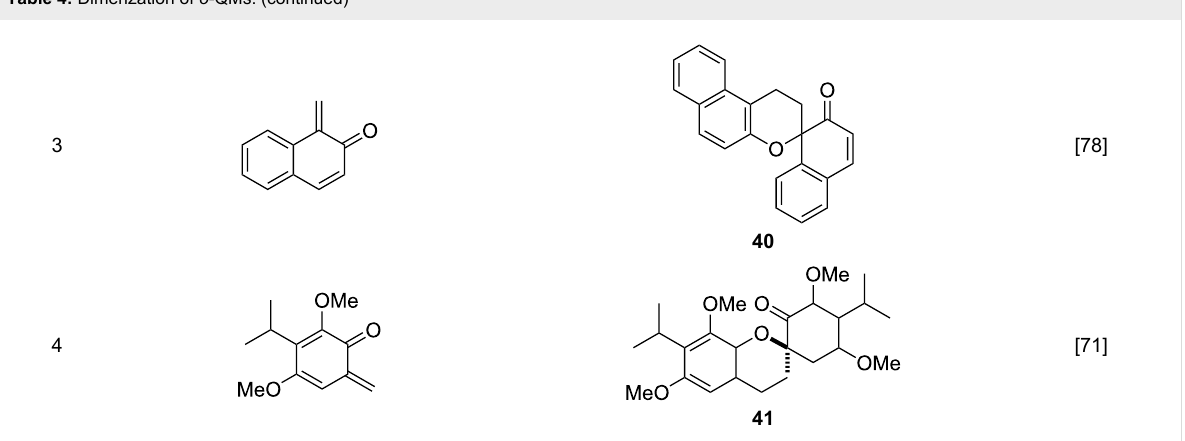
Table 4: Dimerization of o -QMs.